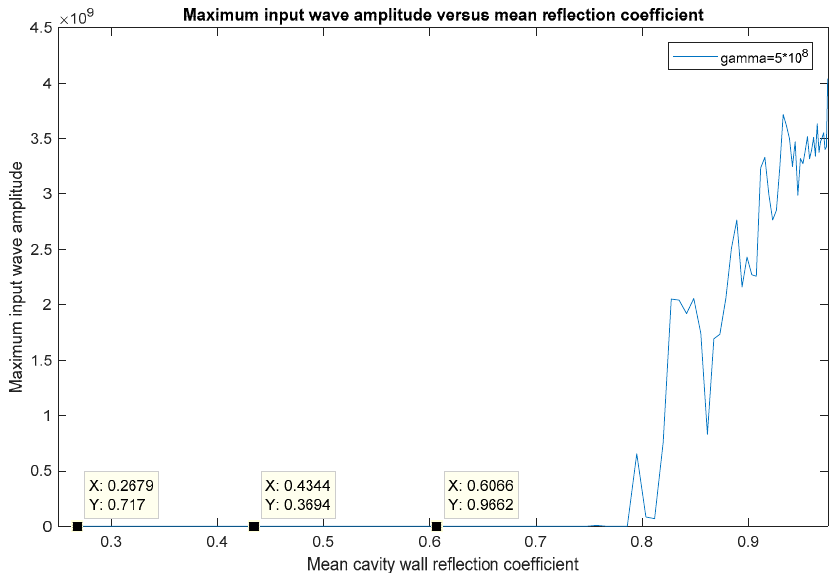
Figure 17. Maximum input wave amplitude at x = 5.73 μ m versus mean cavity wall reflection coefficient for an initial pump wave amplitude of 3.75 × 10 (cid:2876) V/m at 𝑓 (cid:2868) = 8 × 10 (cid:2869)(cid:2872) Hz and for γ = 5 × 10 (cid:2876) .